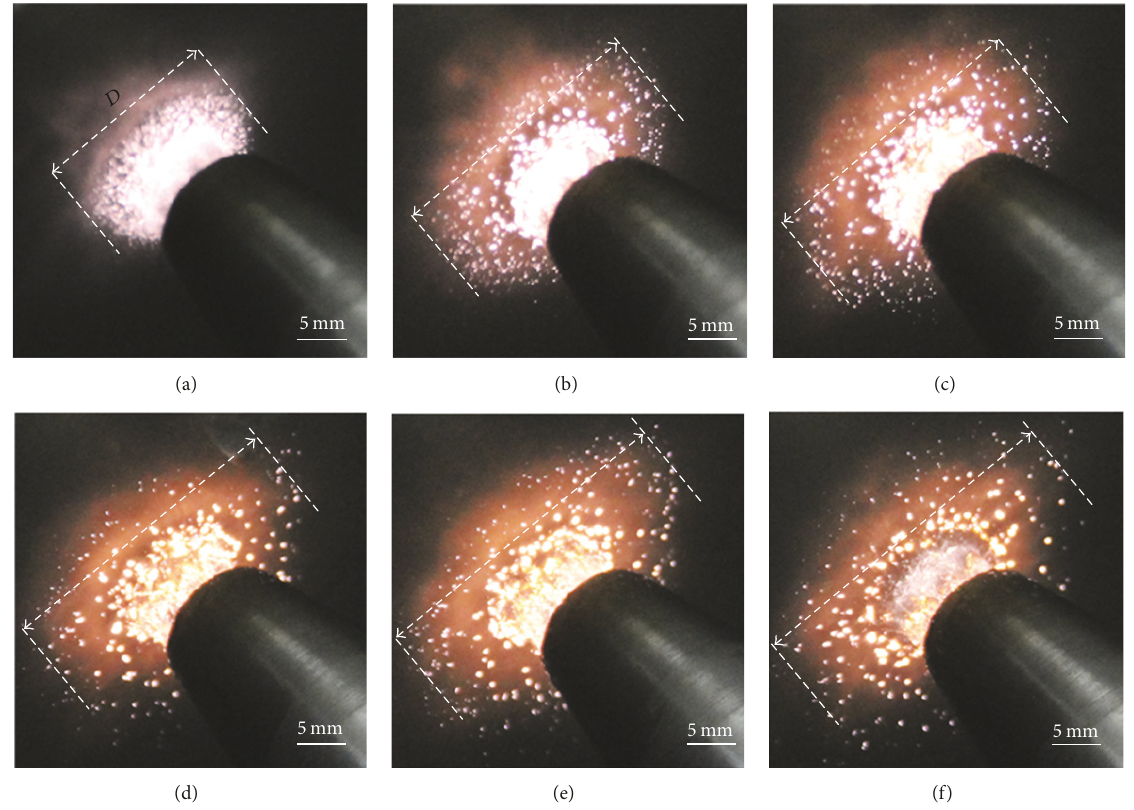
Figure 2: Photographs showing SMAO discharge distributions and diameters taken at (a) 10s, 𝐷 = 19.5 mm; (b) 2 min, 𝐷 = 29.7 mm; (c) 3 min, 𝐷 = 33.9 mm; (d) 5 min, 𝐷 = 35.7 mm; (e) 10min, 𝐷 = 36.9 mm; (f) 15 min, 𝐷 = 37.8